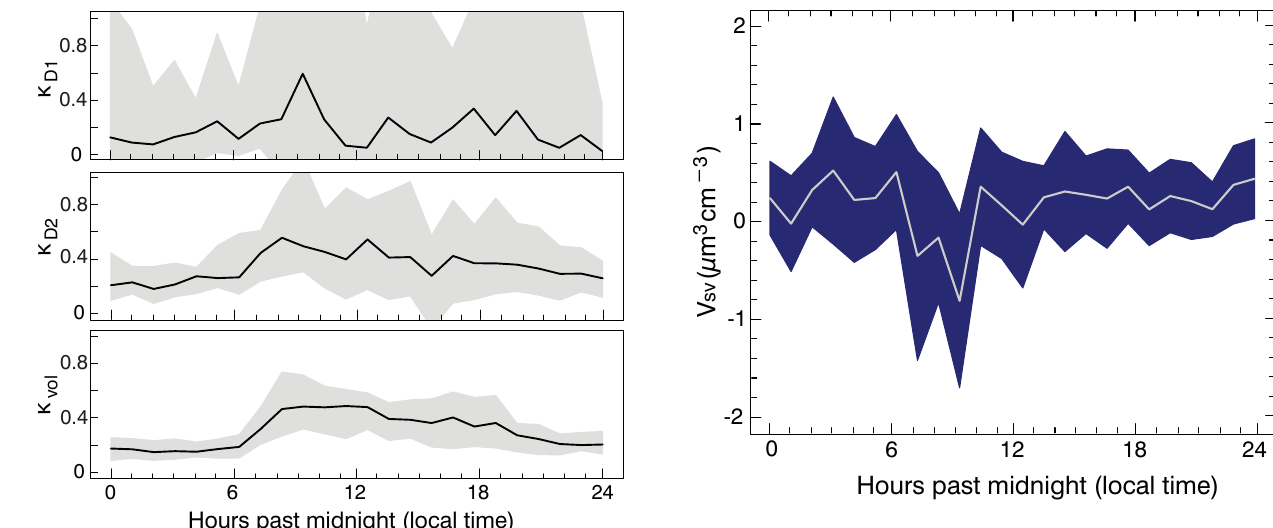
Figure 9. Diurnal trend of semi-volatile volumes lost during dry- ing binned into hourly intervals. The central white line shows the mean of the measurements. The shaded blue area indicates a 95% confidence interval for the